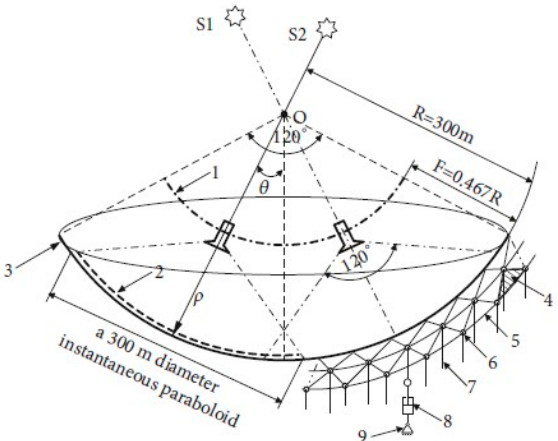
Figure 2. Schematic diagram of the FAST reflector. 1: focusing surface; 2: paraboloid form; 3: basic spherical surface; 4: reflector panel; 5: main cable; 6: cable-net node; 7: pull-down cable; 8: hydraulic actuator; 9: anchor